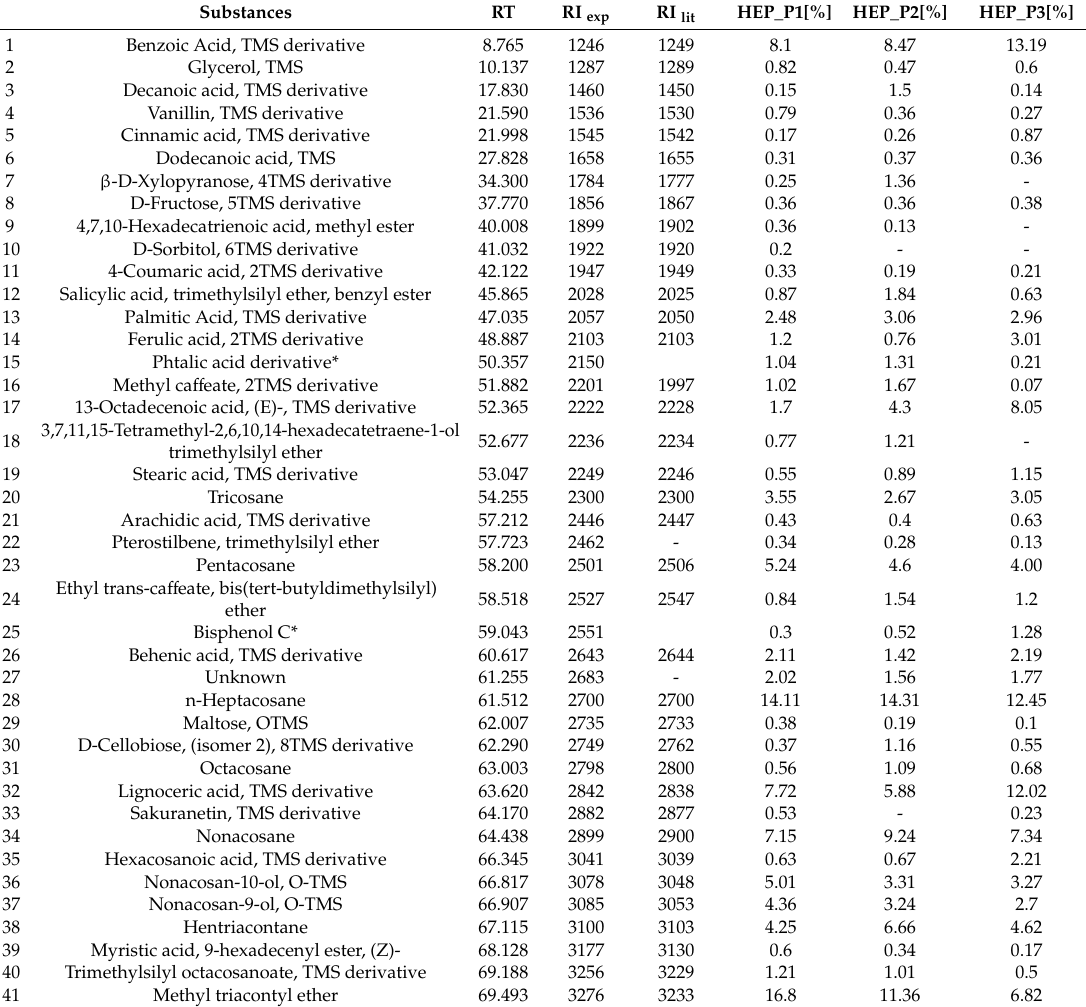
Table A2. GC-MS profile of hexane extracts of propolis (HEP) from di ff erent regions of Poland: HEP_P1 —Podlasie (Hajnowka), HEP_P2 —Masovia (Ciechanow), HEP_P3 —West Pomerania Province (Miedzyzdroje).